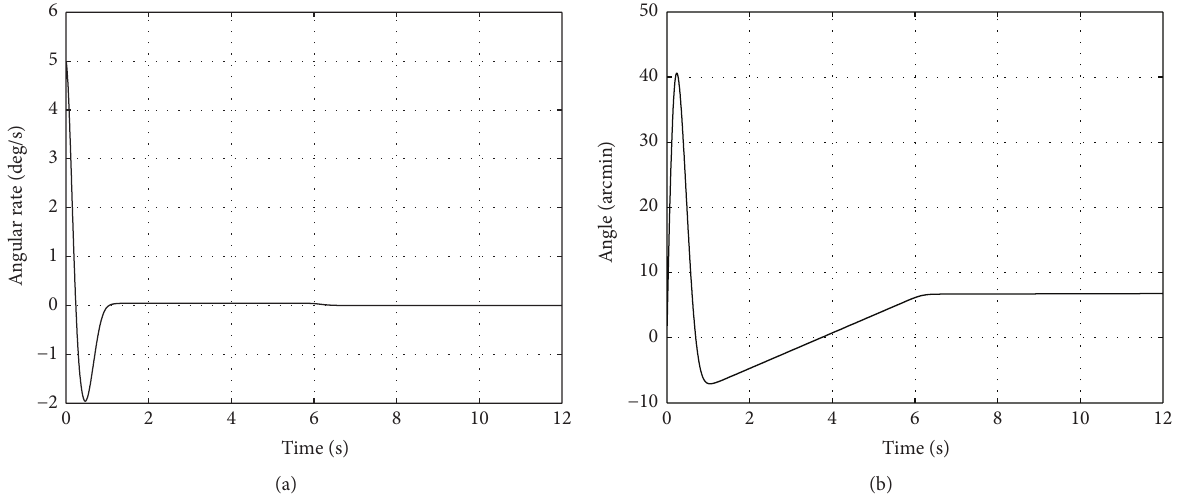
Figure 7: Results of simulation of the platform motion in the mode of prestabilization: (a) is transient of the given angular rate; (b) is error of the angular position determination.